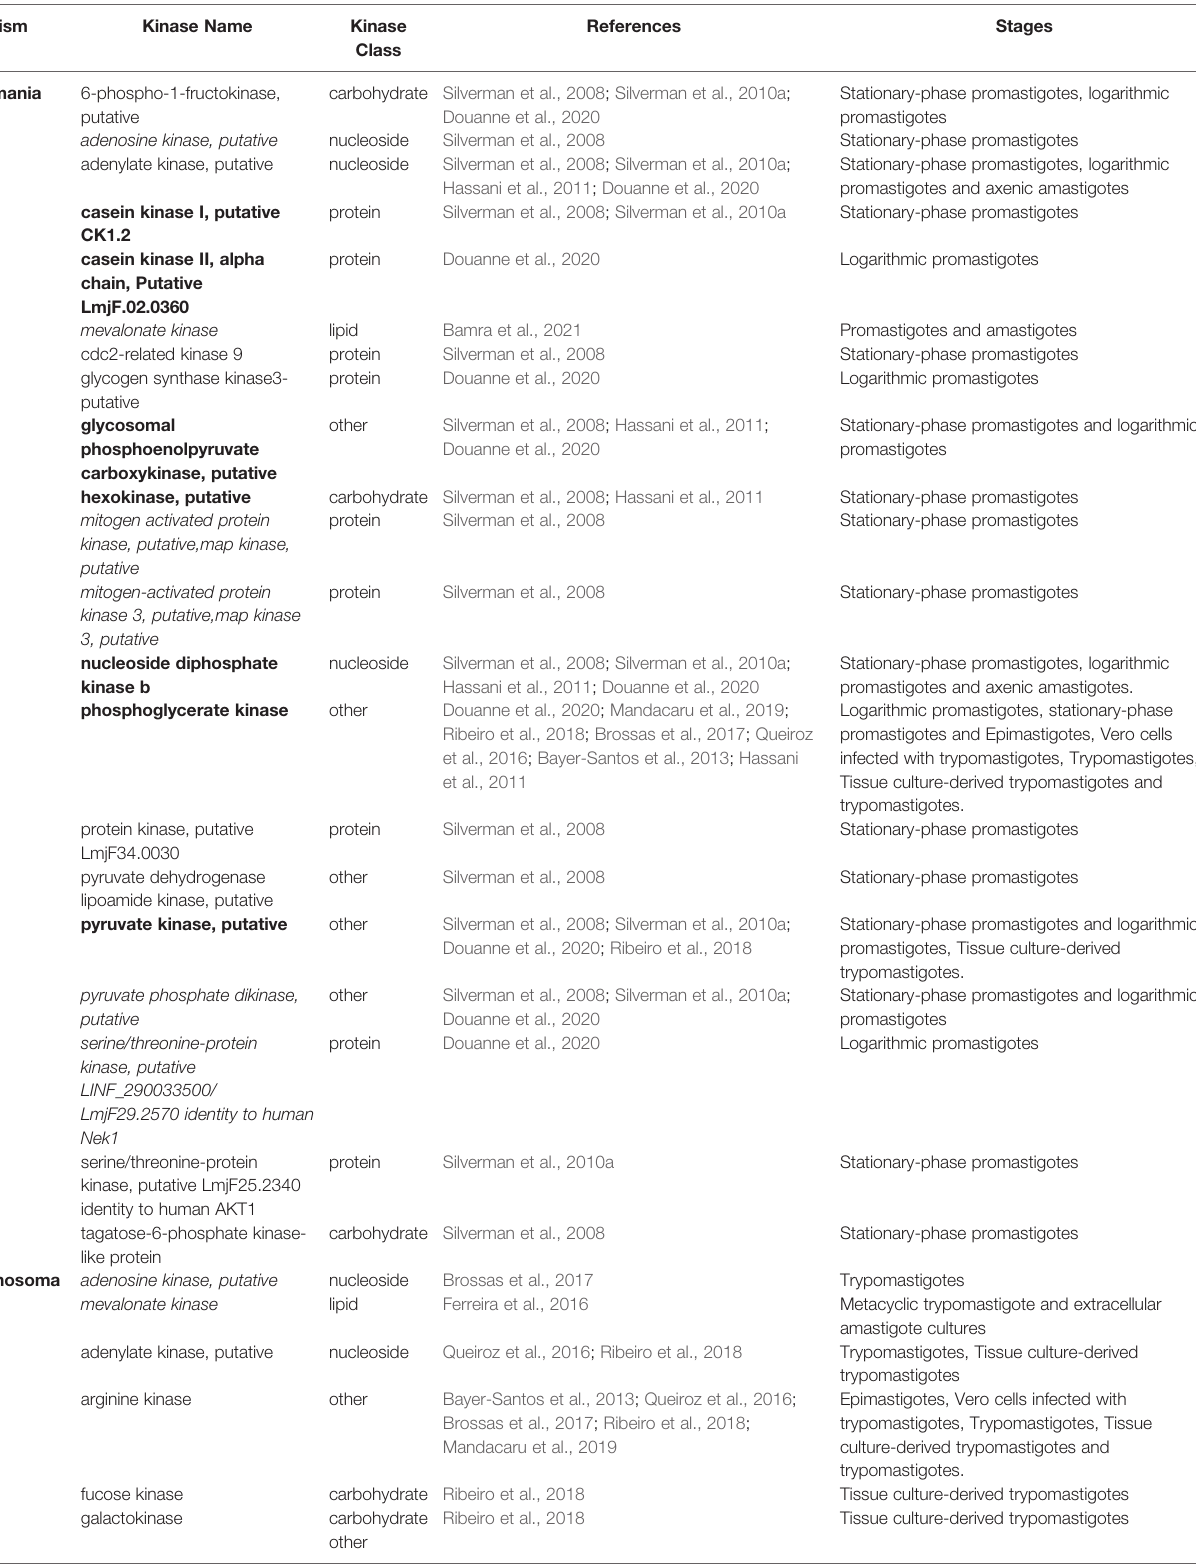
TABLE 1 | Kinases secreted by protozoan parasites.